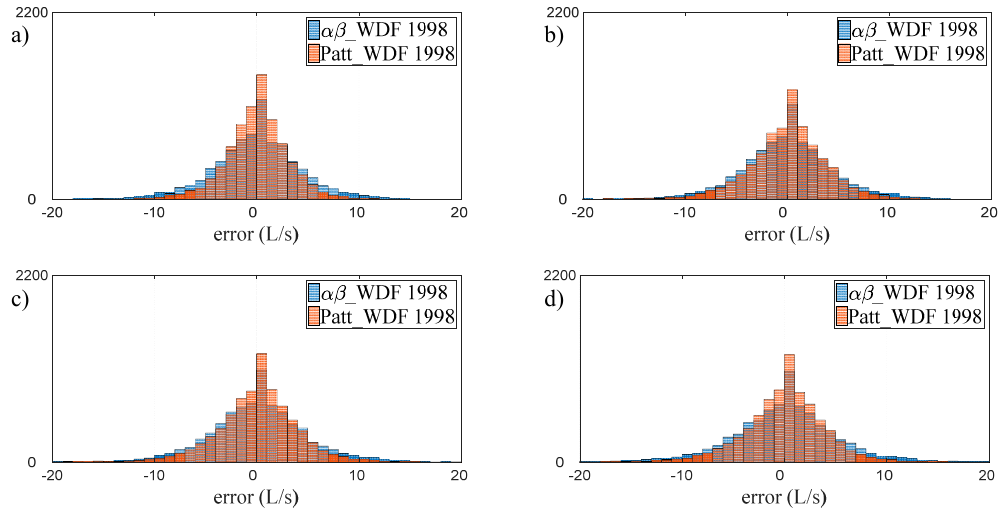
Figure 4. Comparison of the forecasting error frequency histograms of the αβ _WDF and Patt_WDF models for the year 1998 and the time horizons of ( a ) 1 h; ( b ) 6 h; ( c ) 12 h; and ( d ) 24 h.